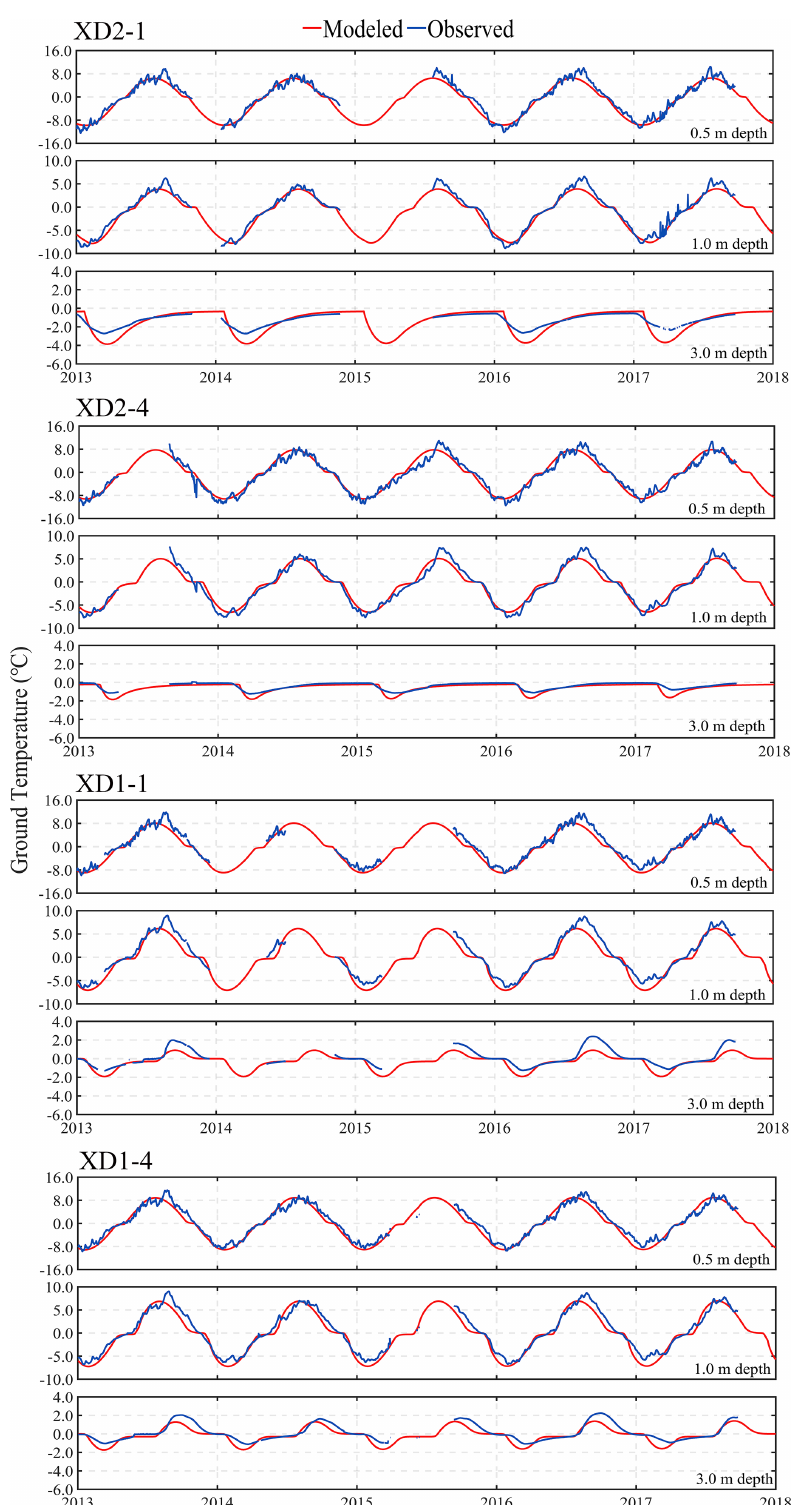
Figure A3. Comparison of the simulated (red lines) to observed (blue lines) daily mean ground temperature at 0.5, 1.0, and 3.0m depth in four validation boreholes (XD2-1, XD2-4, XD1-1, and XD1-4) during the observation period from 2013 to 2018 (there were some data gaps due to temperature probe failure in some years; at XD2-1, the data gaps in the record mainly occurred at 0.5–3.0m in the first half of 2015; at XD1-1, the data gap in the record is at 0.5–3.0m in 2014–2015 and at 8–15m during 2013–2015; at XD1-4, the data gap in the record is in the first half of